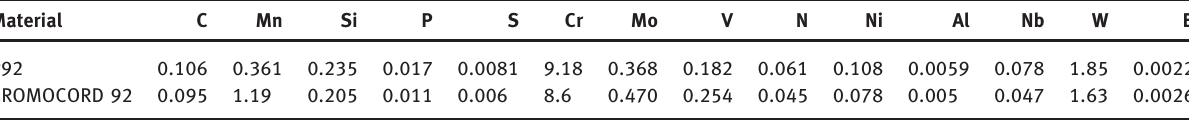
Table 1: Chemical compositions of P92 pipe and CROMOCORD 92 weld filler metal (weight percent). Material